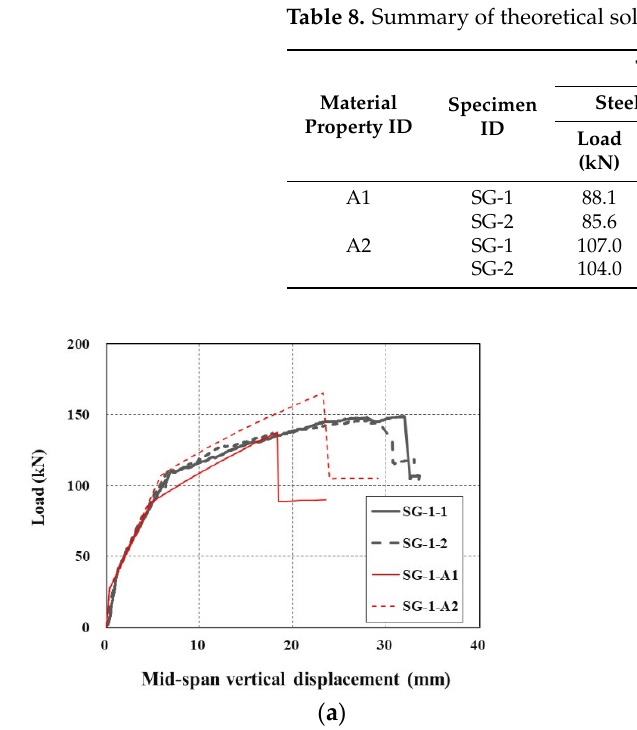
Figure 15. Comparison of theoretical solutions with test results: ( a ) SG ‐ 1 series; and ( b ) SG ‐ 2 series.